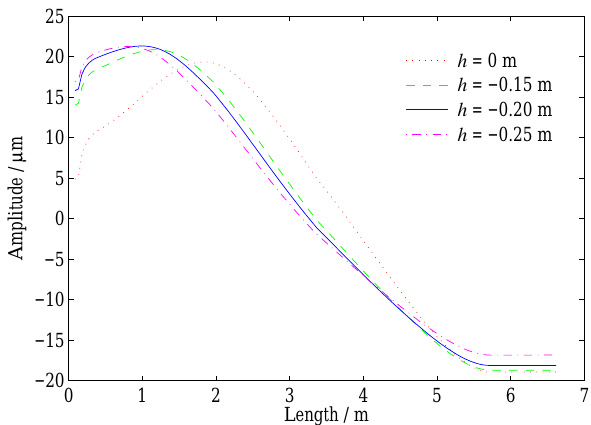
Figure 19. Effect of concrete level on the rotary drum’s vibration